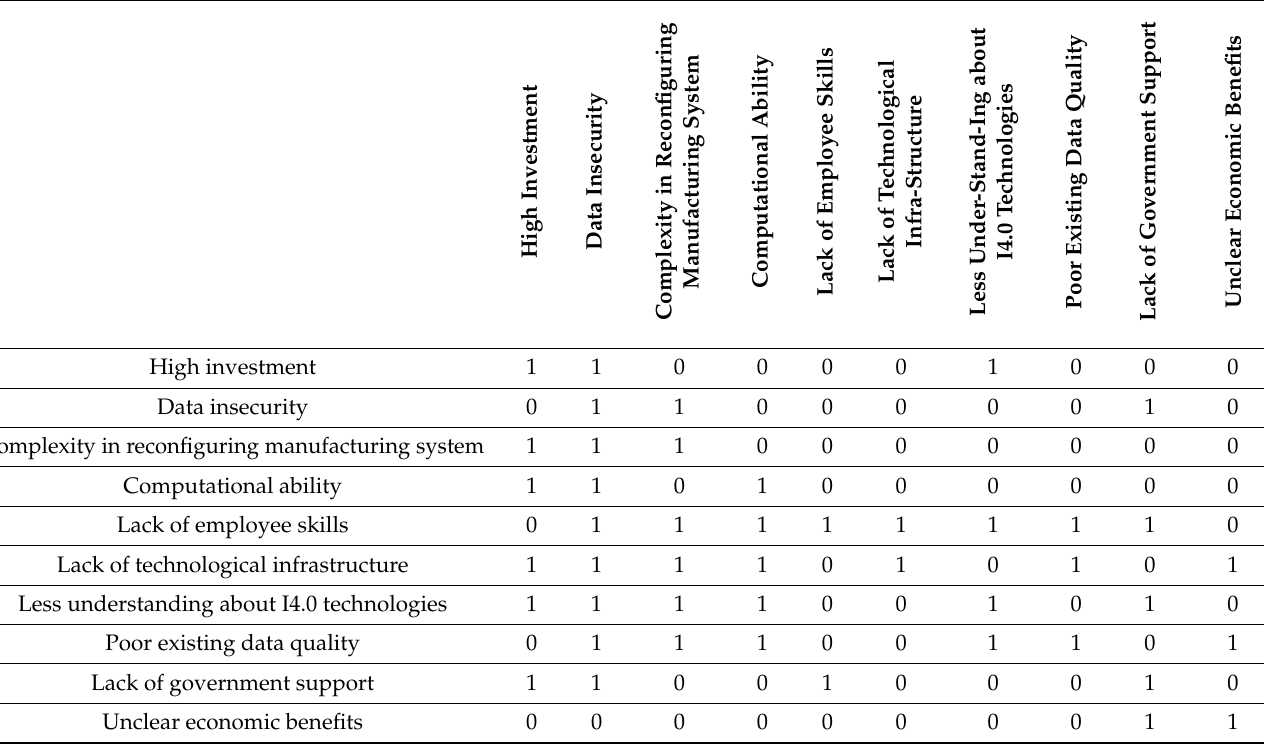
Table 4. Initial reachability matrix for I4.0 challenges.